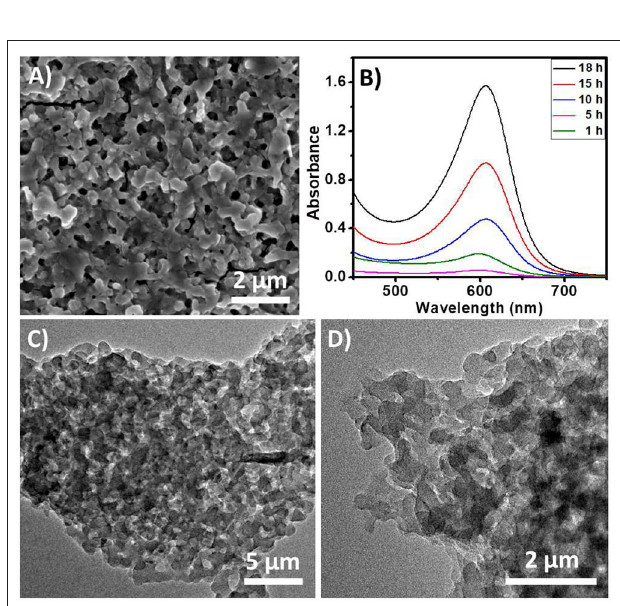
FIGURE 7 | (A) SEM image of the polymer prepared from the hybrid. (B) Time dependent EAS of the polymer in DMSO. (C,D) TEM images of the SOM-polymer